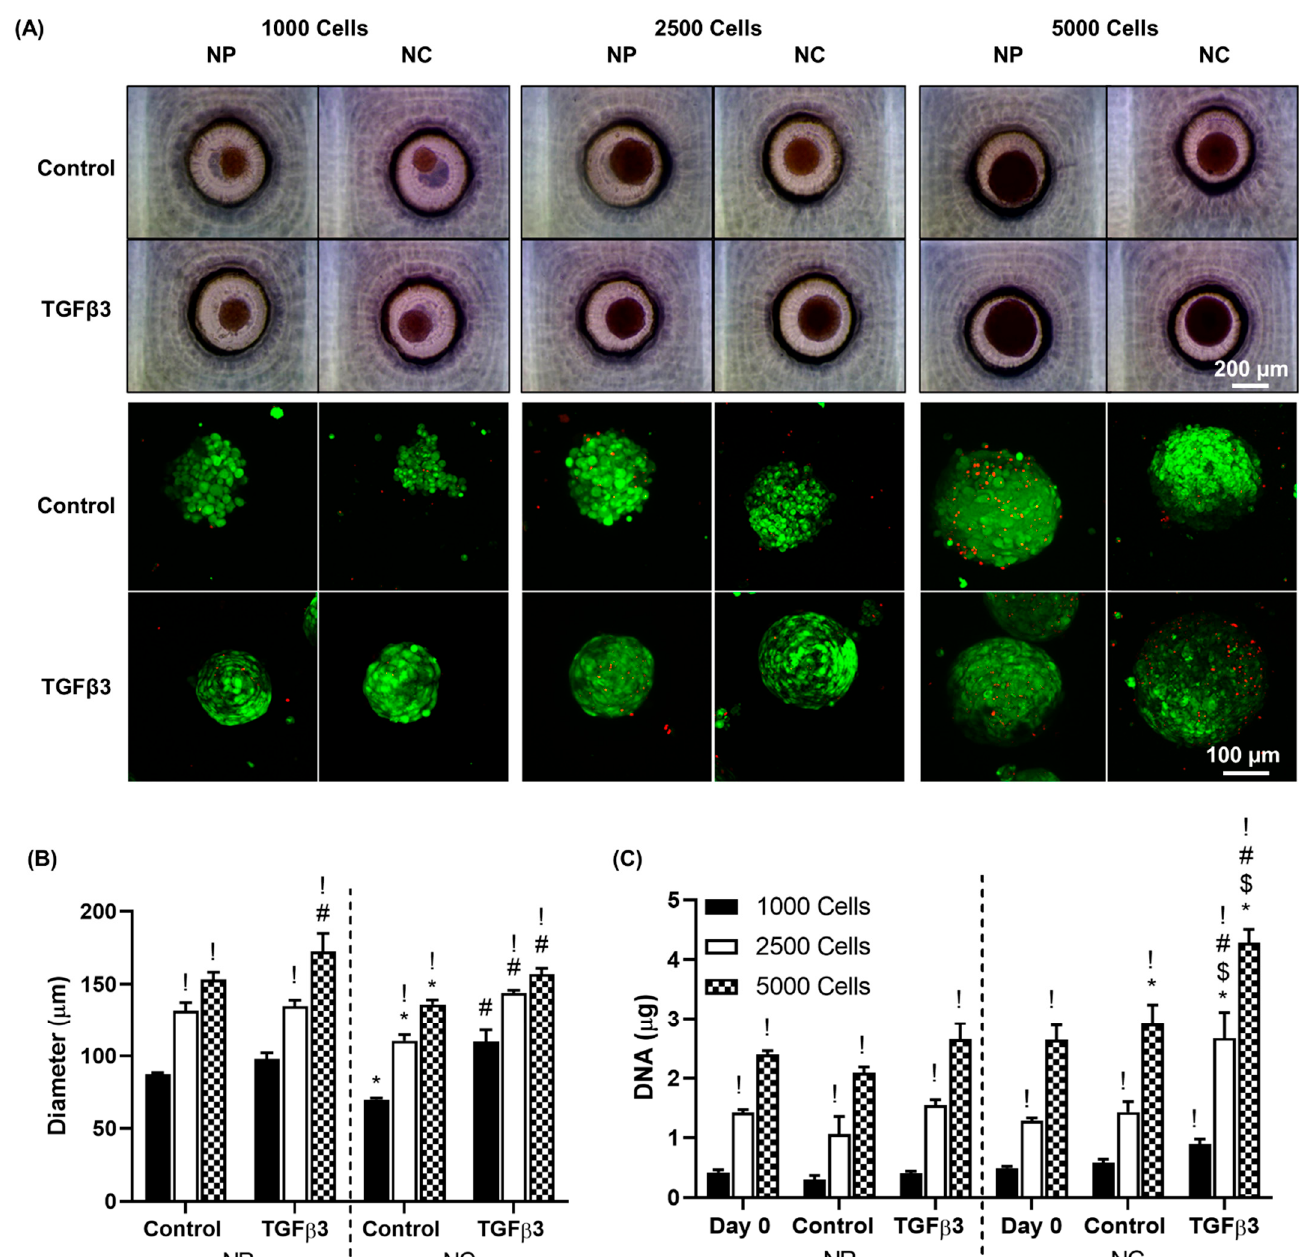
Figure 2. Morphology and viability of microtissues formed using nucleus pulposus (NP) and nasoseptal chondrocyte (NC) cells. ( A ) Representative brightfield and fluorescent Live/Dead ® images demonstrating the morphology and viability of microtissues in microwells seeded with 1000, 2500 and 5000 cells/microwell, after 7 days ( B ) Diameter of microtissues were analysed using ImageJ ( C ) DNA content ( µ g) was determined in digested microtissues from moulds at each timepoint (day 0 or day 7). Data represent mean ± SD of at least three independent experiments performed in triplicate. ! ( p < 0.05) indicates significance compared to 1000 cells/microtissue. # ( p < 0.05) indicates significance compared to the control group for the same cell number. $ ( p < 0.05) indicates significance compared to day 0 for the same cell number. * ( p < 0.05) indicates significance compared to the NP microtissues for the same experimental group and cell